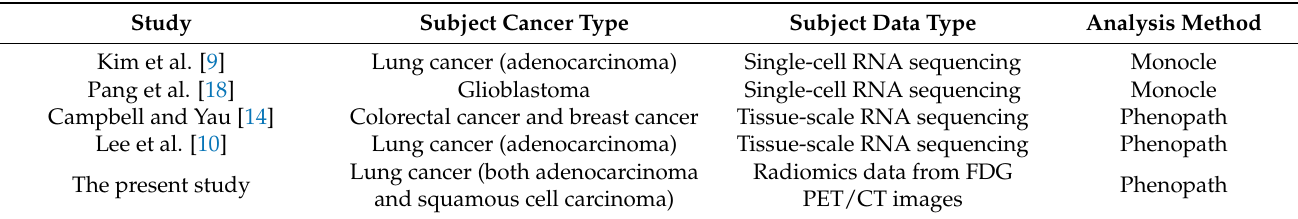
Table 4. A benchmarking table of previous